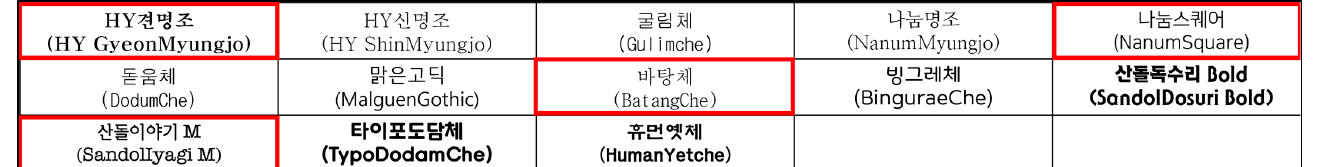
Figure 7. Types of representative fonts used in the experiment .